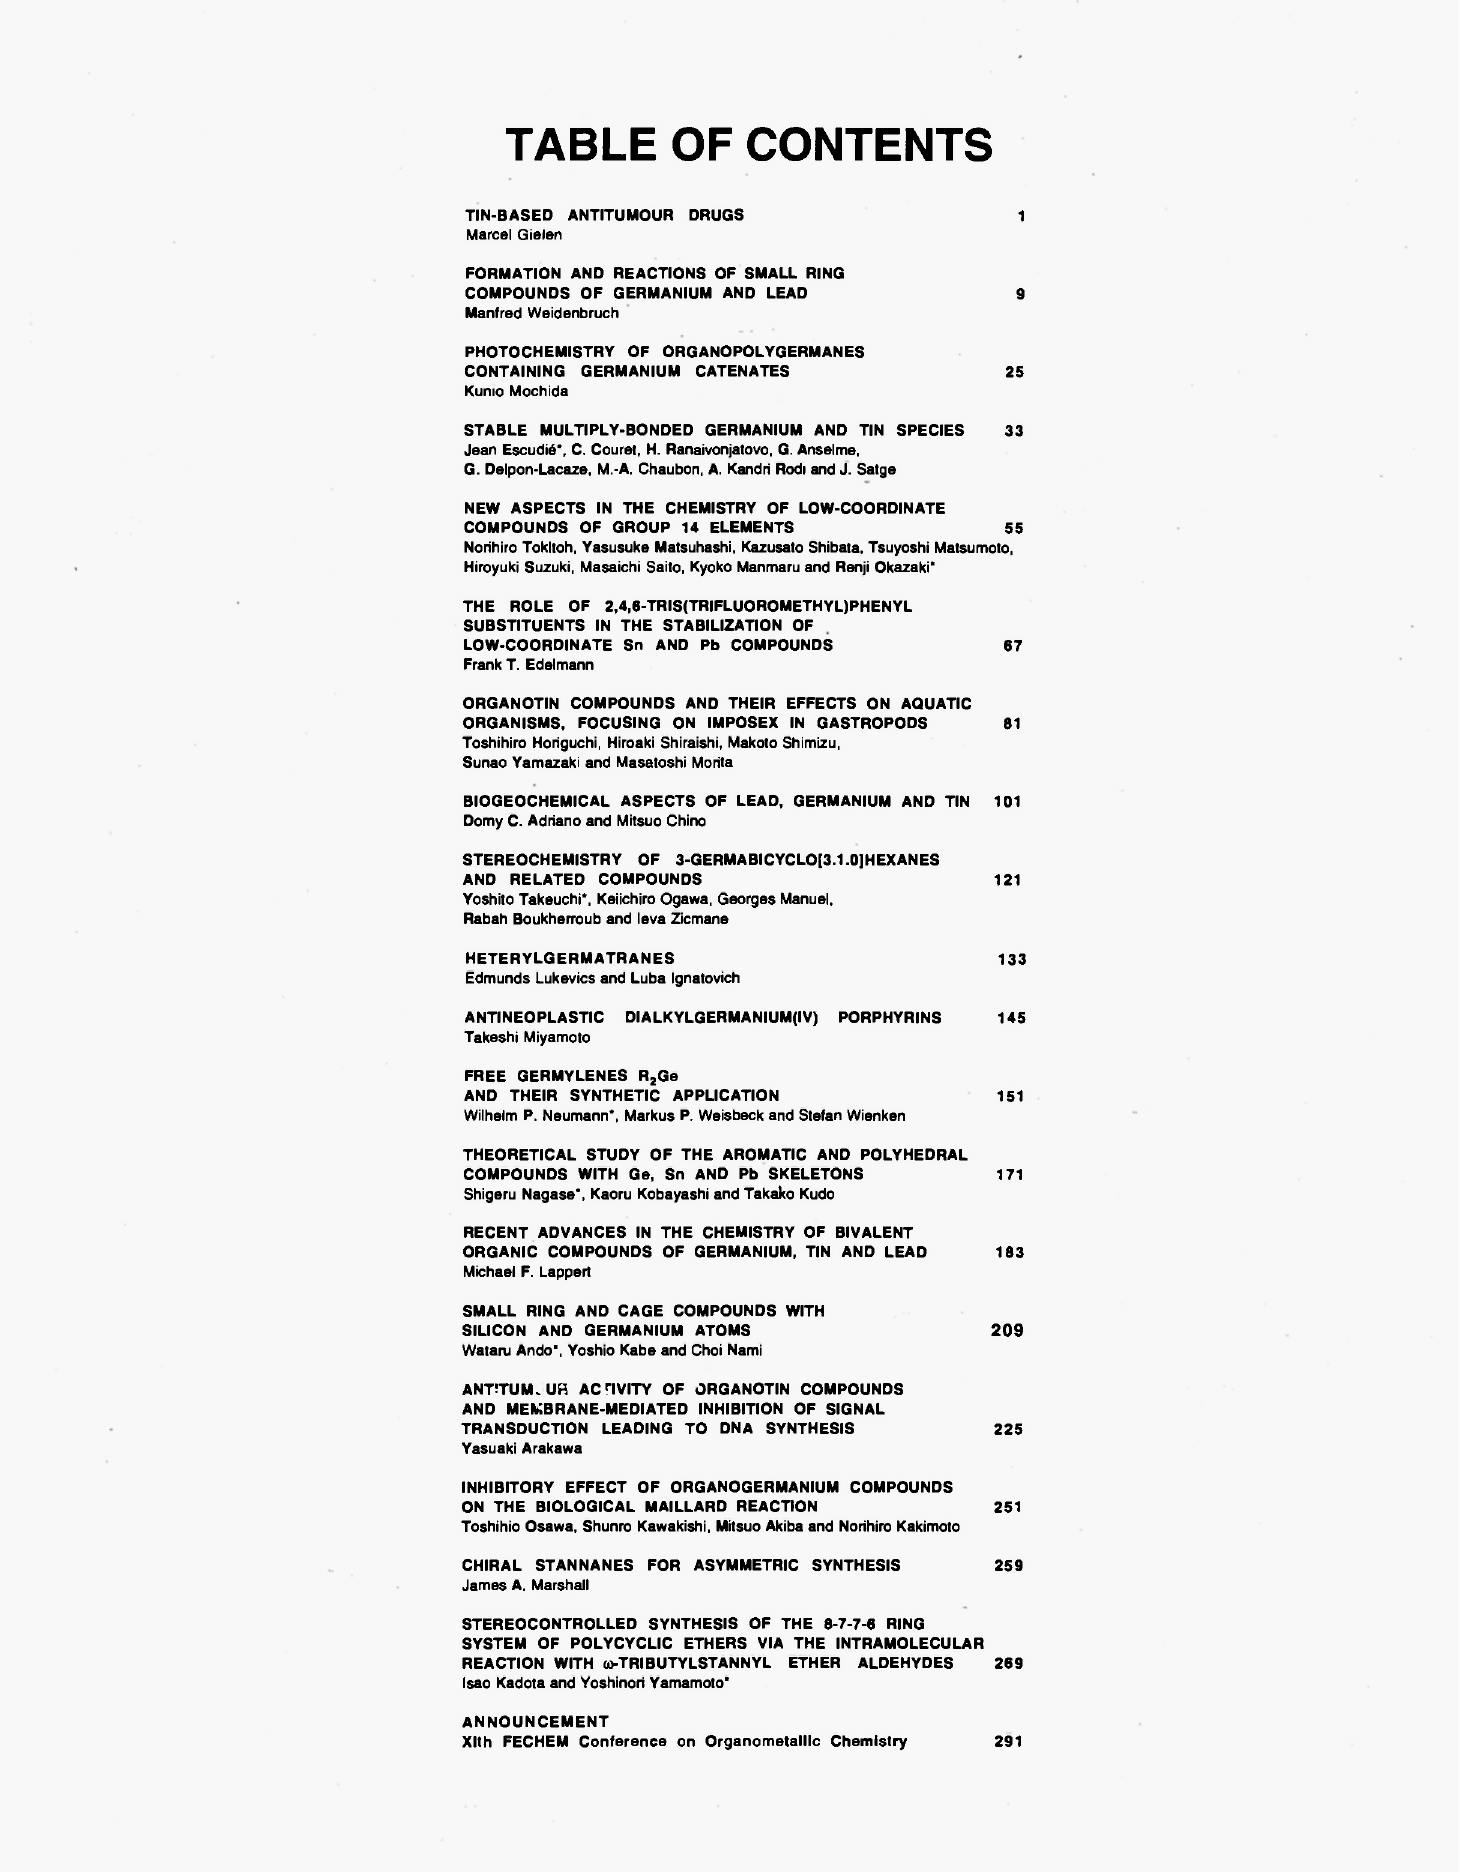
TIN-BASED ANTITUMOUR DRUGS